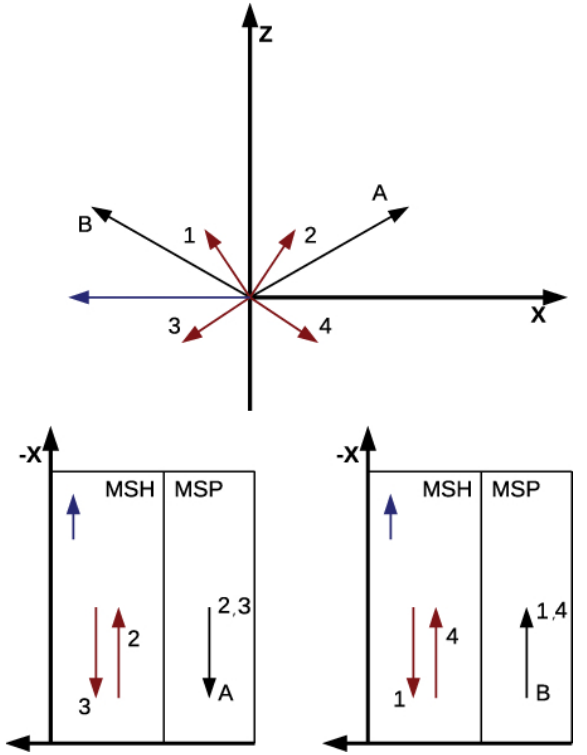
Fig. 4. The top figure shows the possible orientation of the MSP (black arrow) and MSH (red arrow) magnetic field. The bottom figure shows the four possible orientations of the local MHD plot output as seen by the user; Case 1 set the MSH B x orientation as anti-parallel and MSP B x orientation as parallel with respect to the V MSH , Case 2 set the MSH B x orientation as parallel and MSP B x orientation as anti-parallel,with respect to the V MSH , Case 3 set both MSH and MSP B x orientation as anti-parallel with respect to the V MSH , and Case 4 set both MSH and MSP B x orientation to parallel with respect to the V MSH . The red arrows, numbered 1–4, represent each case. The blue arrow represents the V MSH flow. The black arrows, labeled A and B, represent the two possible orien- tations of the B MSP . A represents the B MSP having a component directed toward the Earth and B represents the B MSP flow having a component directed tailward. Table 2 documents the orientations for Events